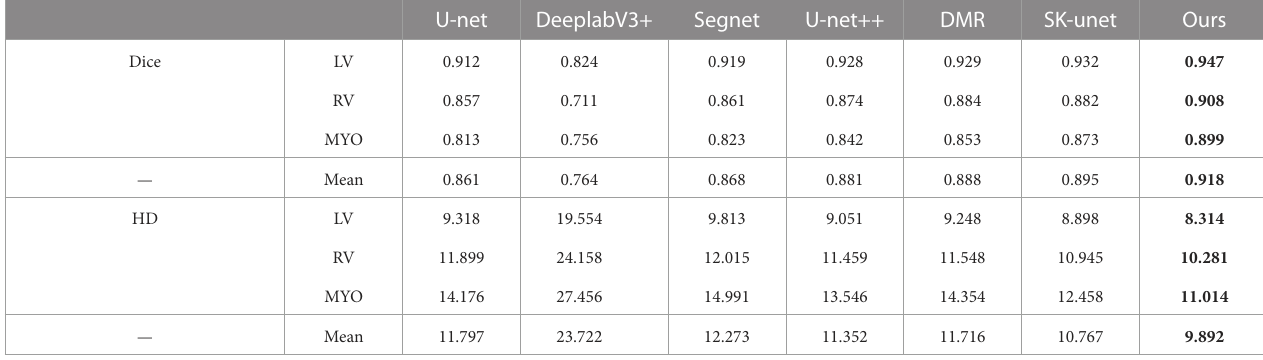
TABLE5 DiceandHDofdifferentsegmentationmodelsonACDCdatasetarecomparedquantitatively.